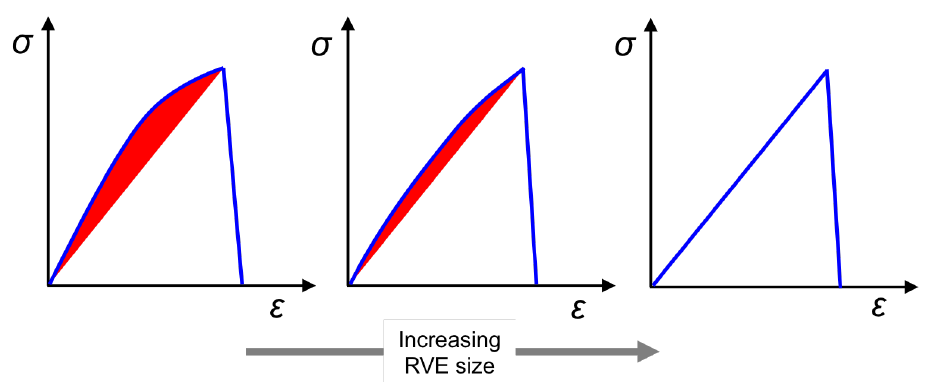
Figure 20. Schematic of the stress–strain response of unit cells with increase in unit cell size. The response of smaller unit cell sizes exhibit pronounced non-linearity owing dissipation in the matrix (shown in red shaded portion) before the peak.